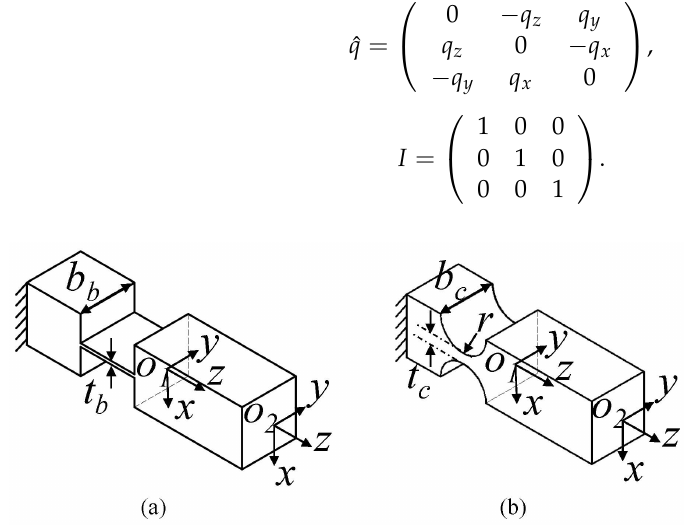
Figure 3. The beam flexure hinge ( a ) and right circular flexure hinge ( b